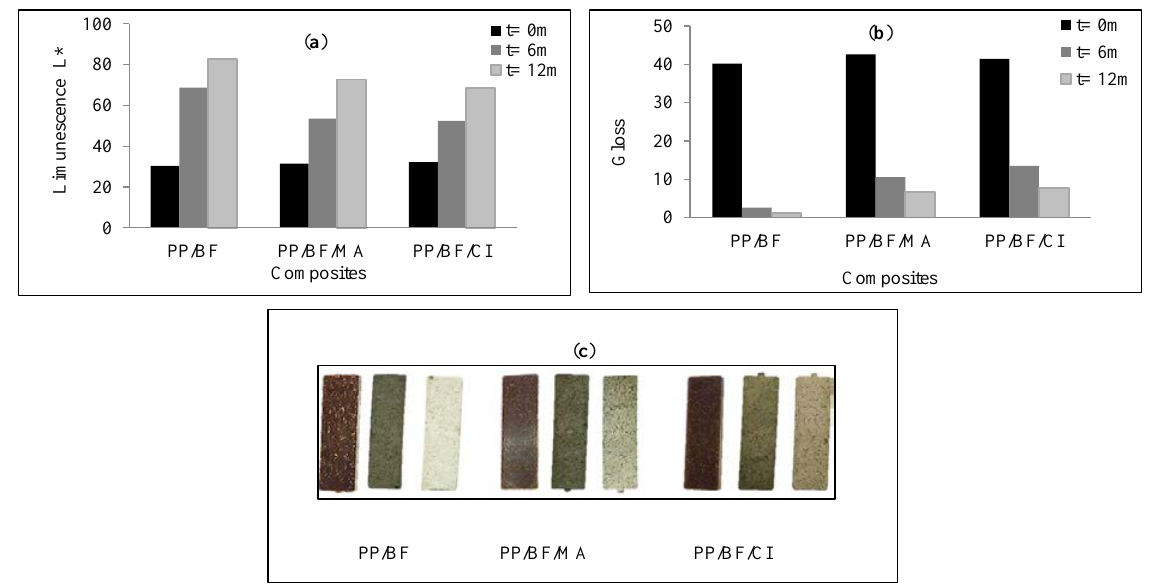
Figure 7. Physical properties: ( a ) Luminescence ( b ) gloss ( c ) photographs of the specimens.